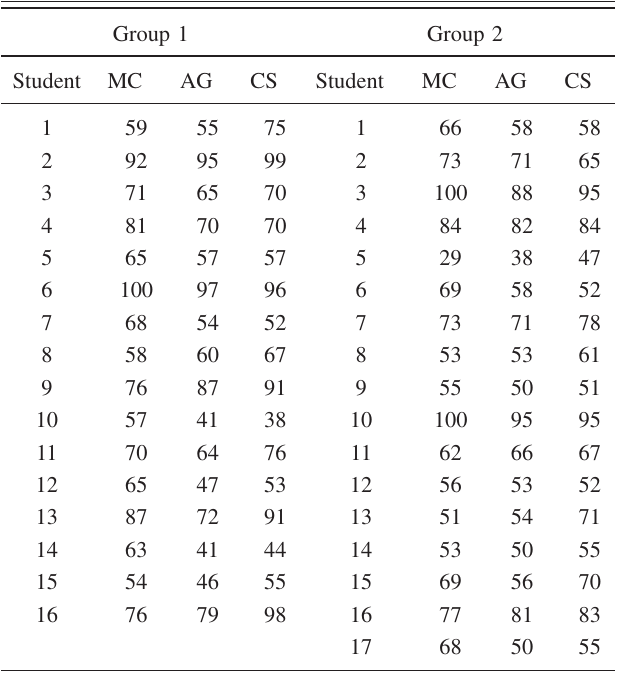
TABLE IV. A list of each student’s mulitple-choice (cid:1) MC (cid:2) , average-grader (cid:1) AG (cid:2) , and committee (cid:1) CS (cid:2) score for those who par- ticipated in the validity study. The data for each group are shown separately.